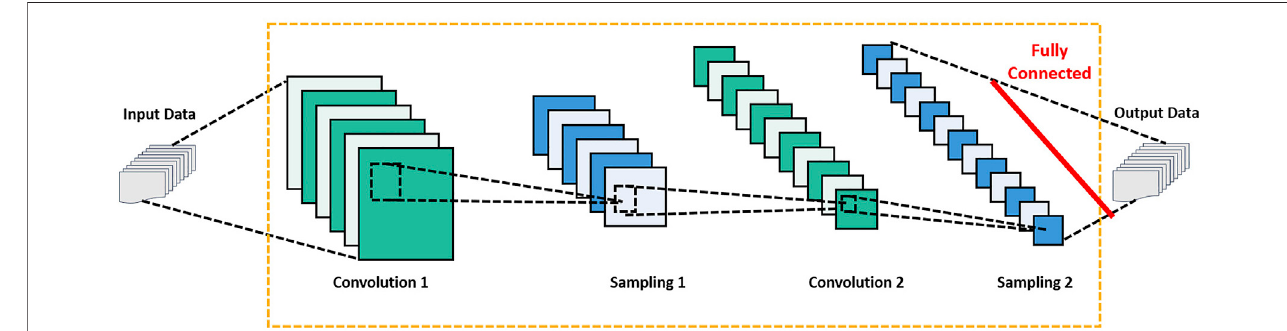
FIGURE 3 | Feature extraction and classi fi cation.